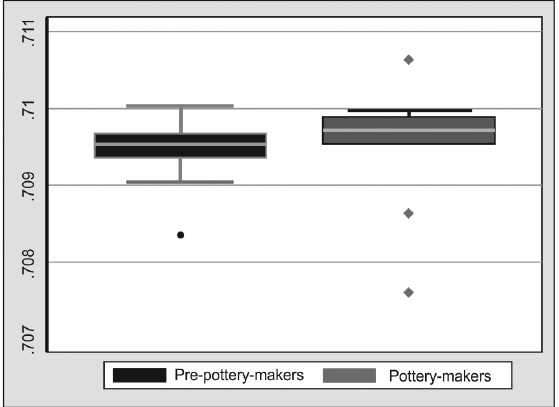
Fig. 2 – Box-plot of the strontium isotope ratios for individuals buried in the archeological sequences with and without pottery in Forte Marechal Luz site. The dashed line shows the present marine stron- tium